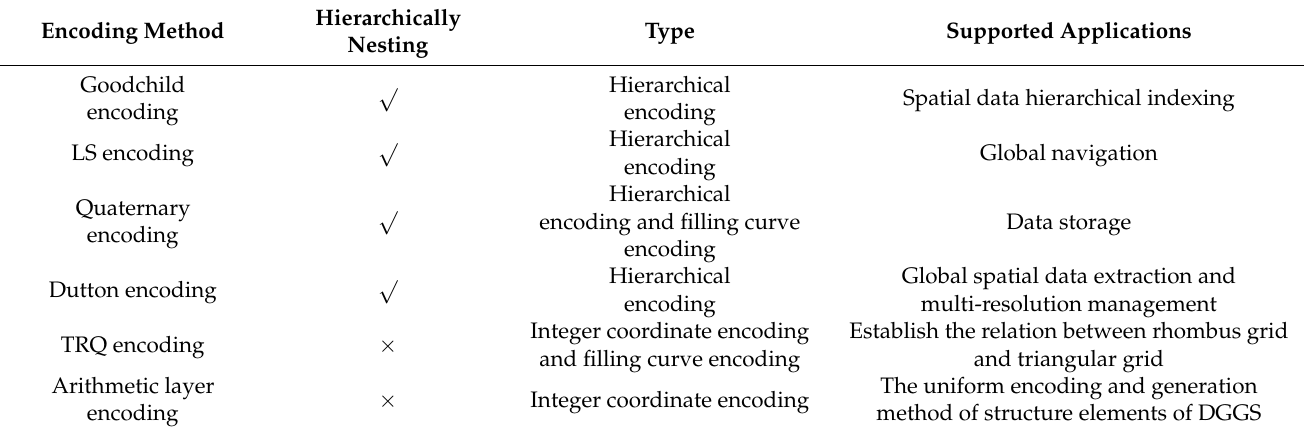
Table 1. Attribute characteristics of QTM encoding.